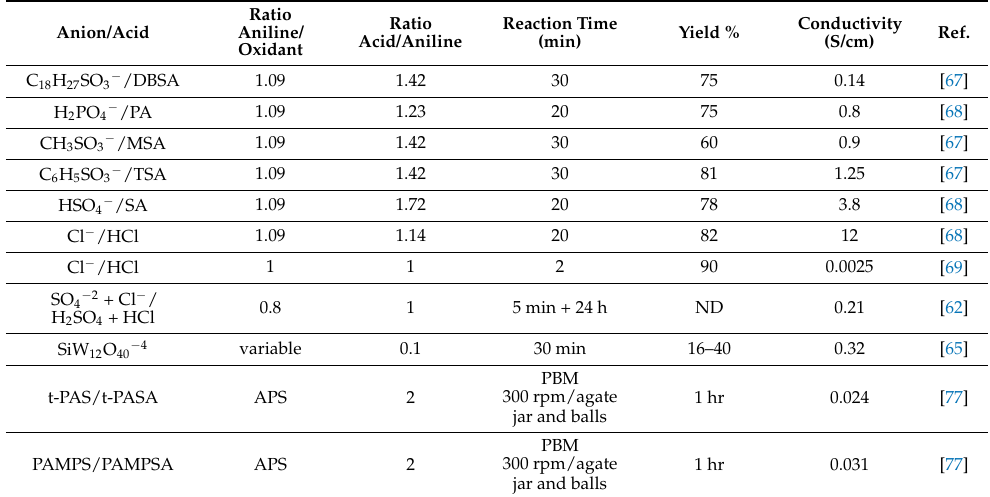
Table 2. Effect of anion dopant on the yield and conductivity of MC synthesized PANI. Anion/Acid